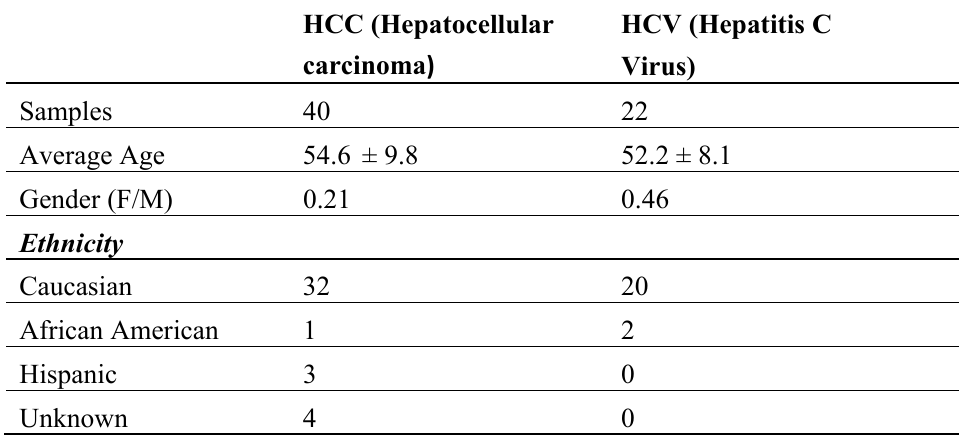
Table 1. Summary of demographic and clinical information for subjects recruited for the